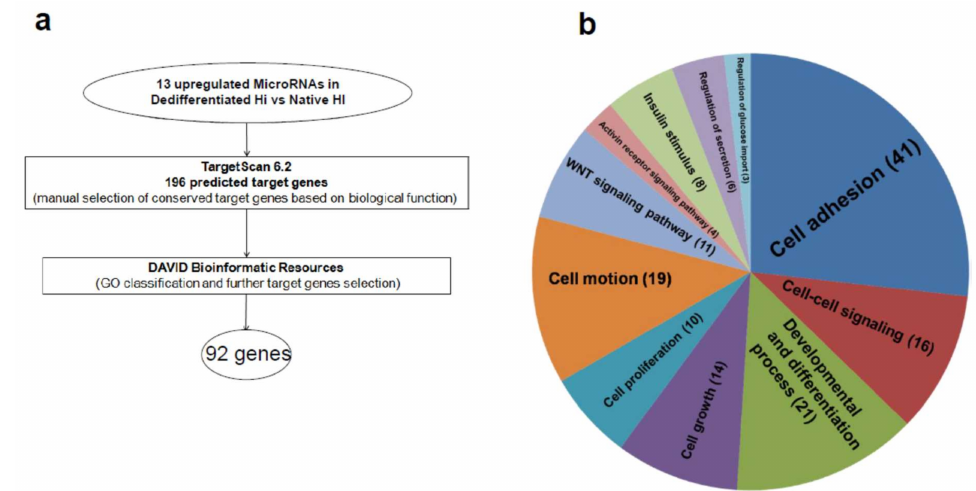
Figure 3. ( a ) Scheme diagram of bioinformatic analysis workflow using Targetscan 6.2 and David 6.7 algorithms. ( b ) Graphical representation of GO terms classification of predicted target genes of upregulated microRNAs: GO Term ID alongside with number of gene included are